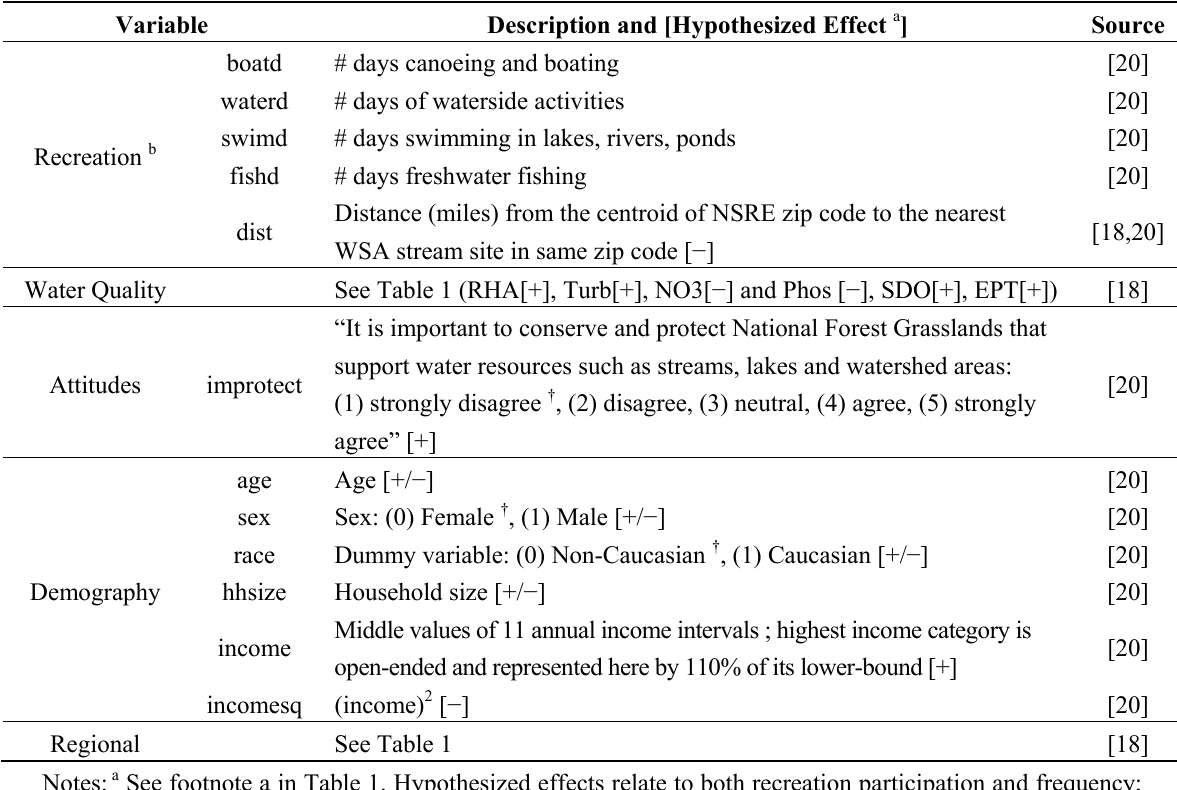
Table 2. Variables used in Case Study